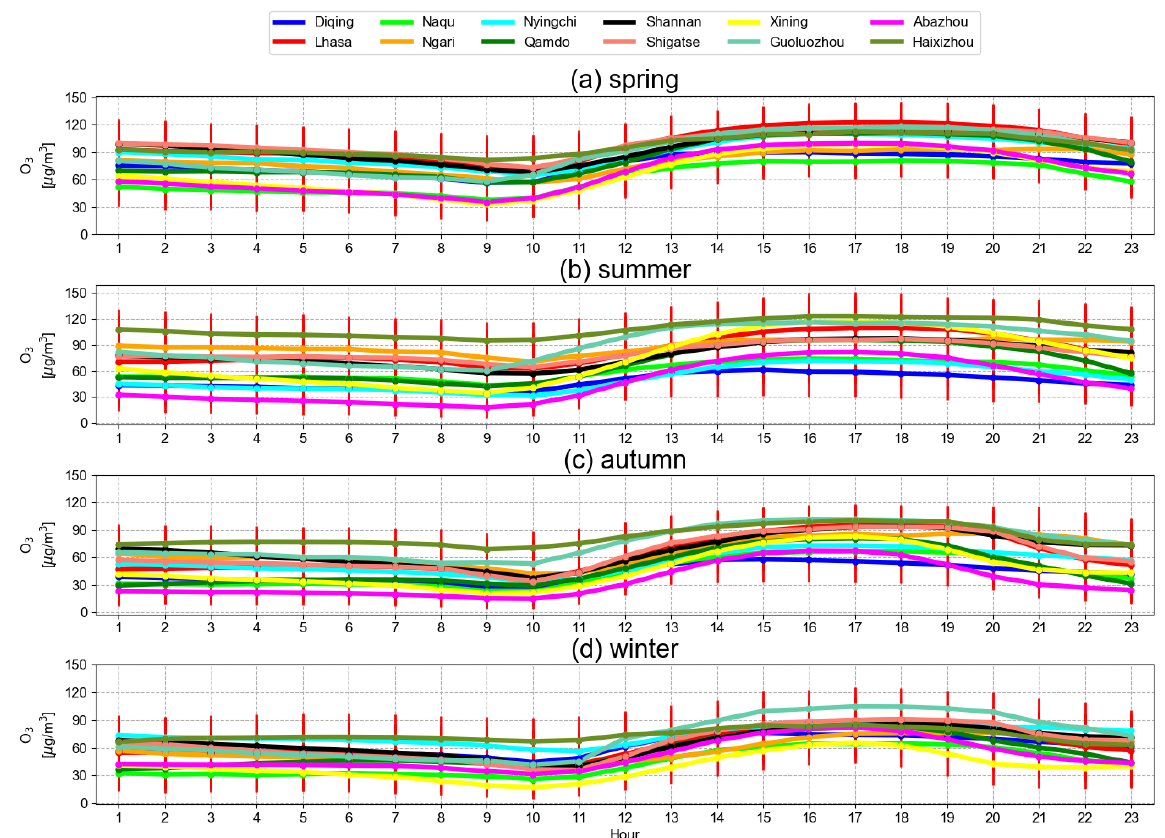
Figure 3. Diurnal cycle of surface ozone (units: µgm − 3 ) in each season and each city over the QTP. The vertical error bar is 1 σ standard variation (SD) within that